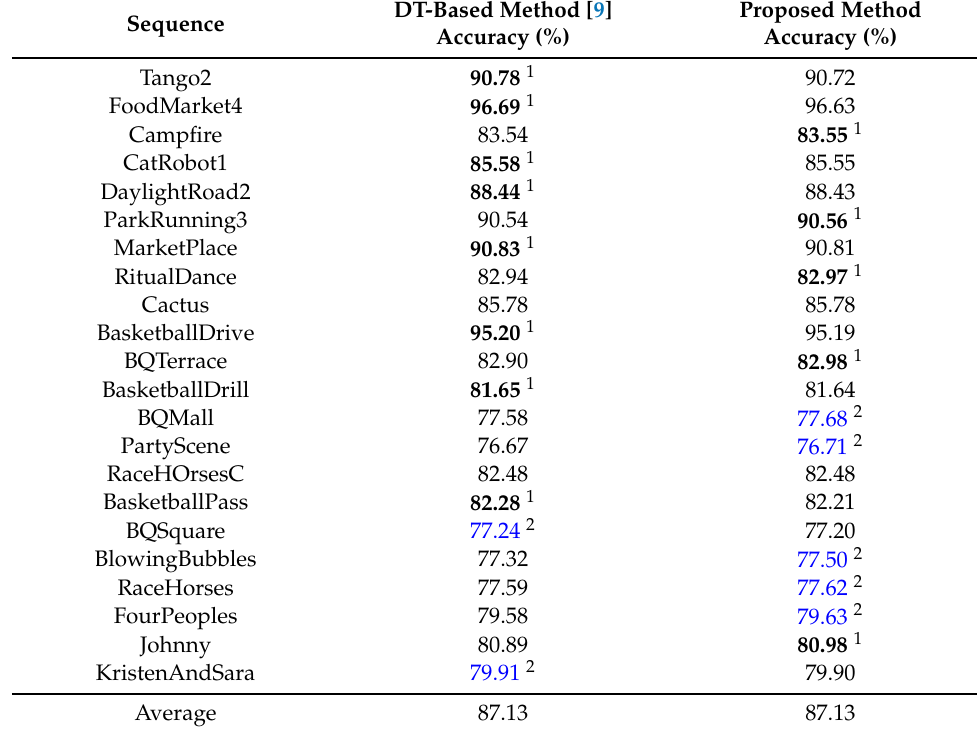
Table 7. Accuracy of the DT-based and proposed method regarding the TT_V